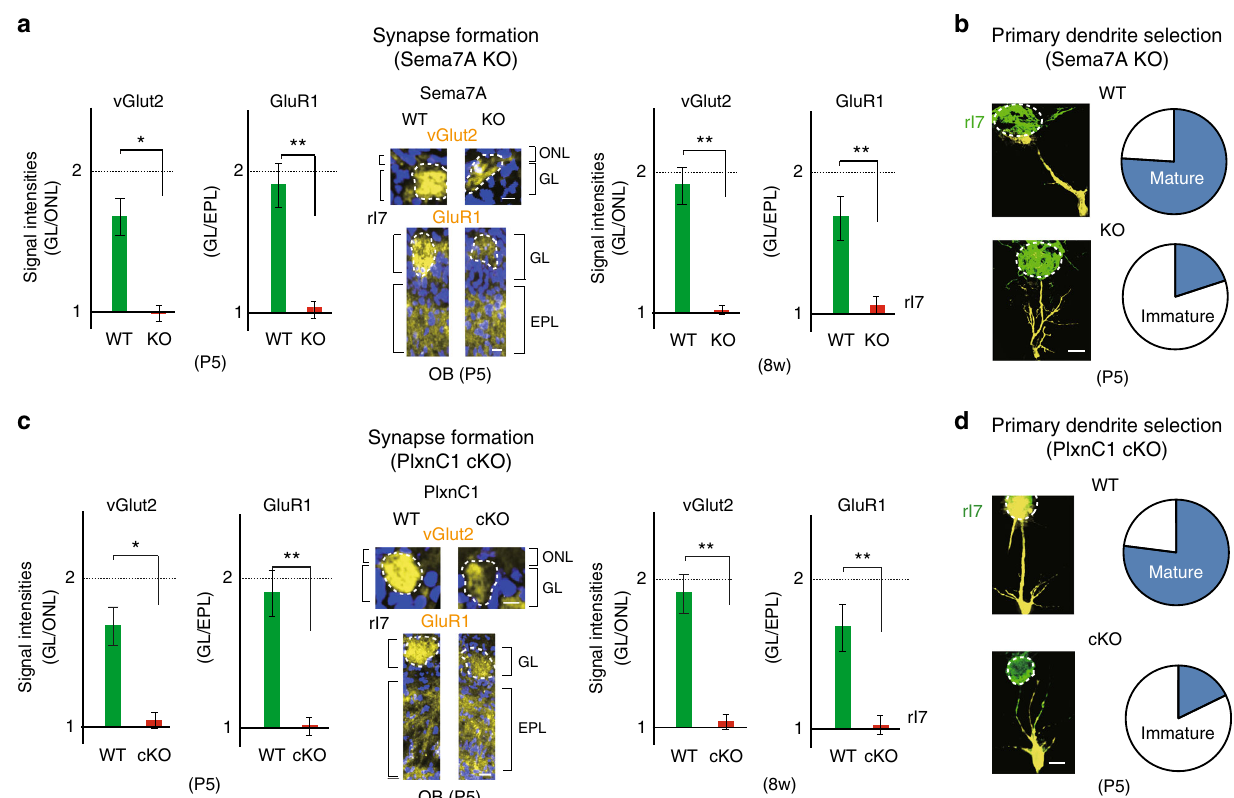
Fig. 4 Synapse formation and dendrite maturation in the Sema7A and PlxnC1 KOs. a Synapse markers within glomeruli in the Sema7A KO. OB sections of the WT and Sema7A KO at P5 and 8w were immunostained with antibodies against vGlut2 and GluR1, pre- and post-synaptic markers, respectively. Staining photos are shown for P5 sections. Signal intensities within the rI7 glomeruli were normalized by the pre-synaptic signals in the ONL and post synaptic signals in the EPL. Fluorescent signals of GL/ONL and GL/EPL in glomeruli are compared between the WT and Sema7A KO. Scale bars = 25 μ m. * p < 0.05, ** p < 0.01 (Student ’ s t -test). Error bars indicate SD ( n = 5, 6, 2, 3 animals). b Dendrite morphology of M/T cells in the Sema7A KO. EYFP-tagged rI7 glomeruli (green) were detected by immunostaining with anti-GFP antibodies. M/T cells (yellow) were visualized by Lucifer yellow (LY) injection into the rI7 glomeruli of the WT and Sema7A KO at P5 (left). The numbers of M/T cells with one dendrite (mature) and those with multiple dendrites (immature) to GL were counted for the rI7 glomeruli. The ratios (%) of mature (blue) and immature (white) M/T cells are shown (right): WT, 26/34 (76.5 %); KO, 8/ 34 cells (23.5 %). n = 20 glomeruli. Scale bar = 10 μ m. c Synapse markers within glomeruli in the PlxnC1 cKO. OB sections of the WT and PlxnC1 cKO at P5 and 8w were analyzed for synapse markers. Staining photos are shown for P5 sections. Signal intensities within the rI7 glomeruli were shown. Scale bars = 25 μ m. * p < 0.05, ** p < 0.01 (Student ’ s t -test). Error bars indicate SD ( n = 5, 5, 2, 3 animals). d Dendrite morphology in the PlxnC1 cKO. M/T cells (yellow) were visualized by LY injection into the rI7 glomeruli of the WT and PlxnC1 cKO at P5 (left). The ratios (%) of mature (blue) and immature (white) M/T cells are shown (right): WT, 24/31 (77.4 %); KO, 7/31 (22.6 %). n = 23 glomeruli. Scale bar = 20 μ